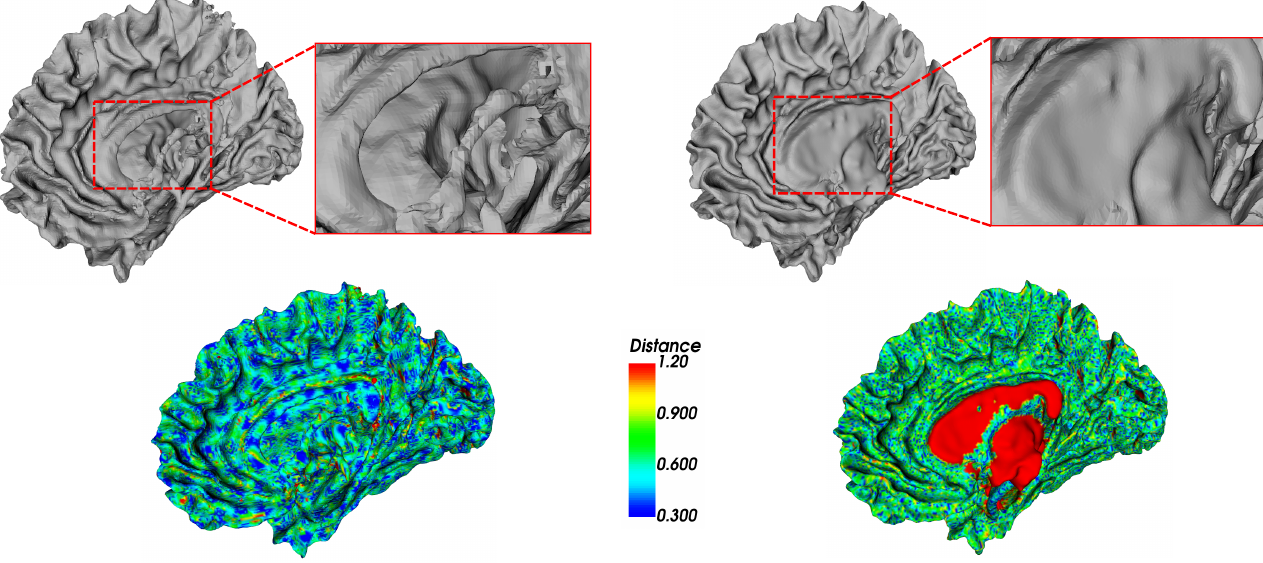
Figure 9. Two examples of the reconstruction of the white matter of the brain with our method in green and FreeSurfer in blue. ( a ) FreeSurfer surface is not properly reconstructed, some details are missing. ( b ) FreeSurfer is unable to push enough the surface area through the narrow opening.